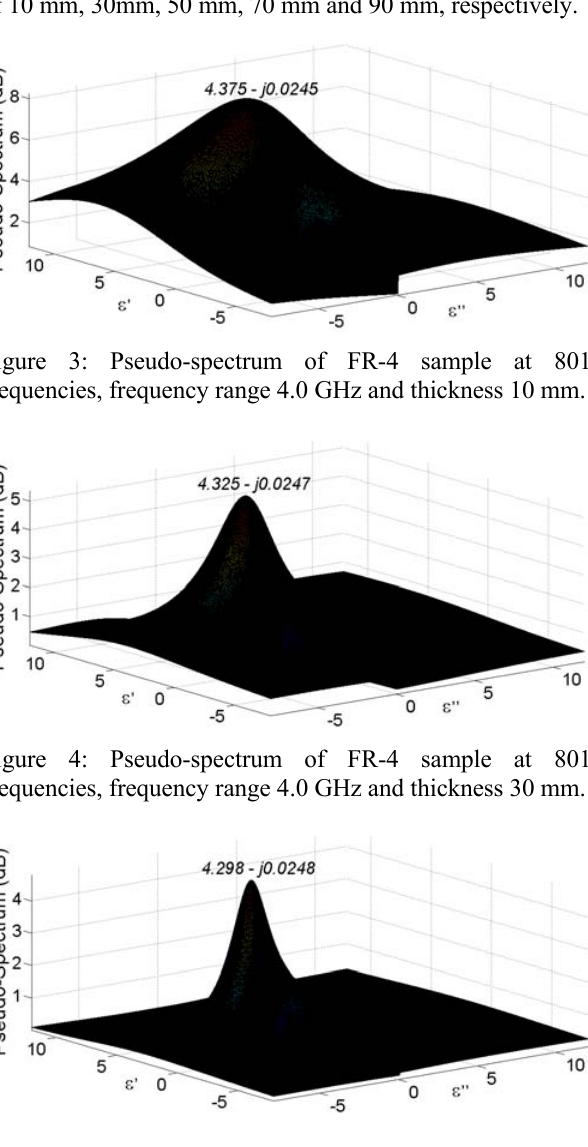
Figure 5: Pseudo-spectrum of FR-4 sample at 801 frequencies, frequency range 4.0 GHz and thickness 50 mm.